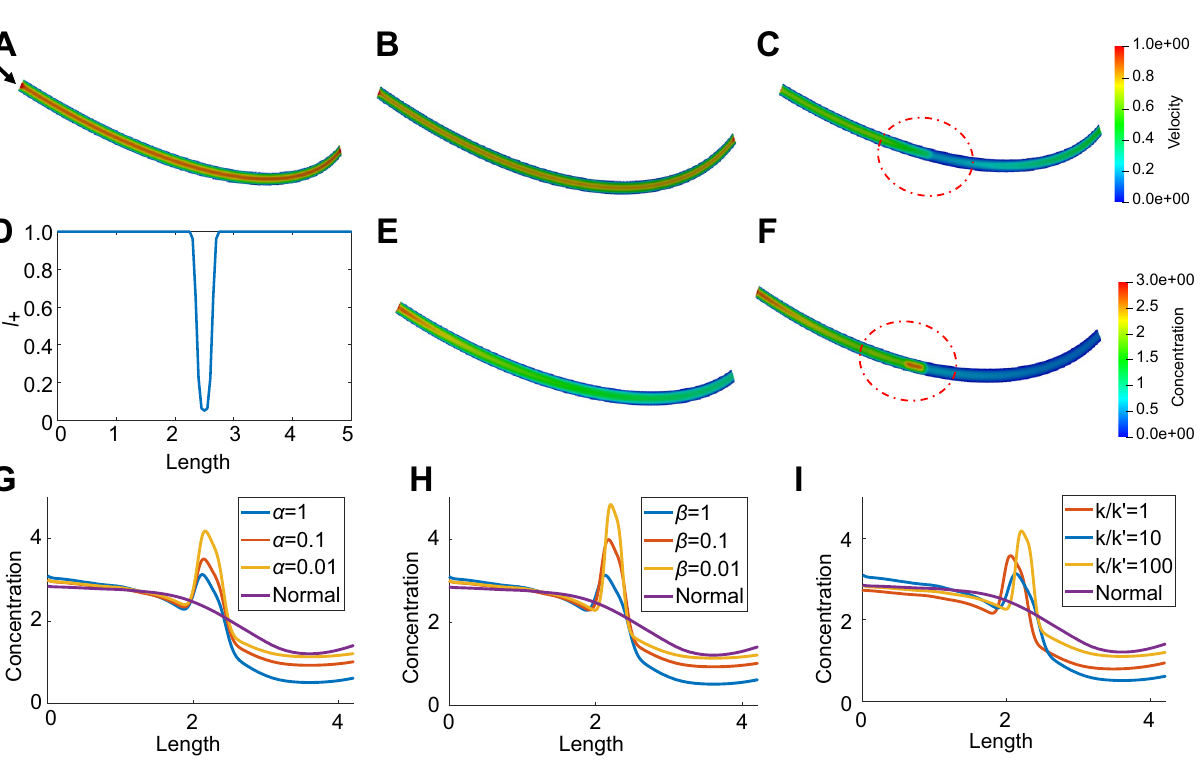
Figure 2. Simulation of material transport and parameter analysis in a single pipe geometry. ( A ) The predefined velocity field V + . Black arrow points to the inlet of the pipe. The computed velocity field in ( B ) a healthy neuron and ( C ) an abnormal neuron with reduced MTs in the red dashed circle region. ( D ) Distribution of l + to model the traffic jam caused by the reduction of MTs. Distribution of concentration ( n 0 + n + ) in ( E ) a healthy neuron and ( F ) an abnormal neuron with reduced MTs in the red dashed circle region. ( G – I ) The concentration curve ( n 0 + n + ) on the centerline of the single pipe affected by different settings of ( G ) α ; ( H ) β ; 2 and ( I ) k / k ′ . Unit for color bars: ( A – C ) µ m/s and ( E , F ) mol/ µ m